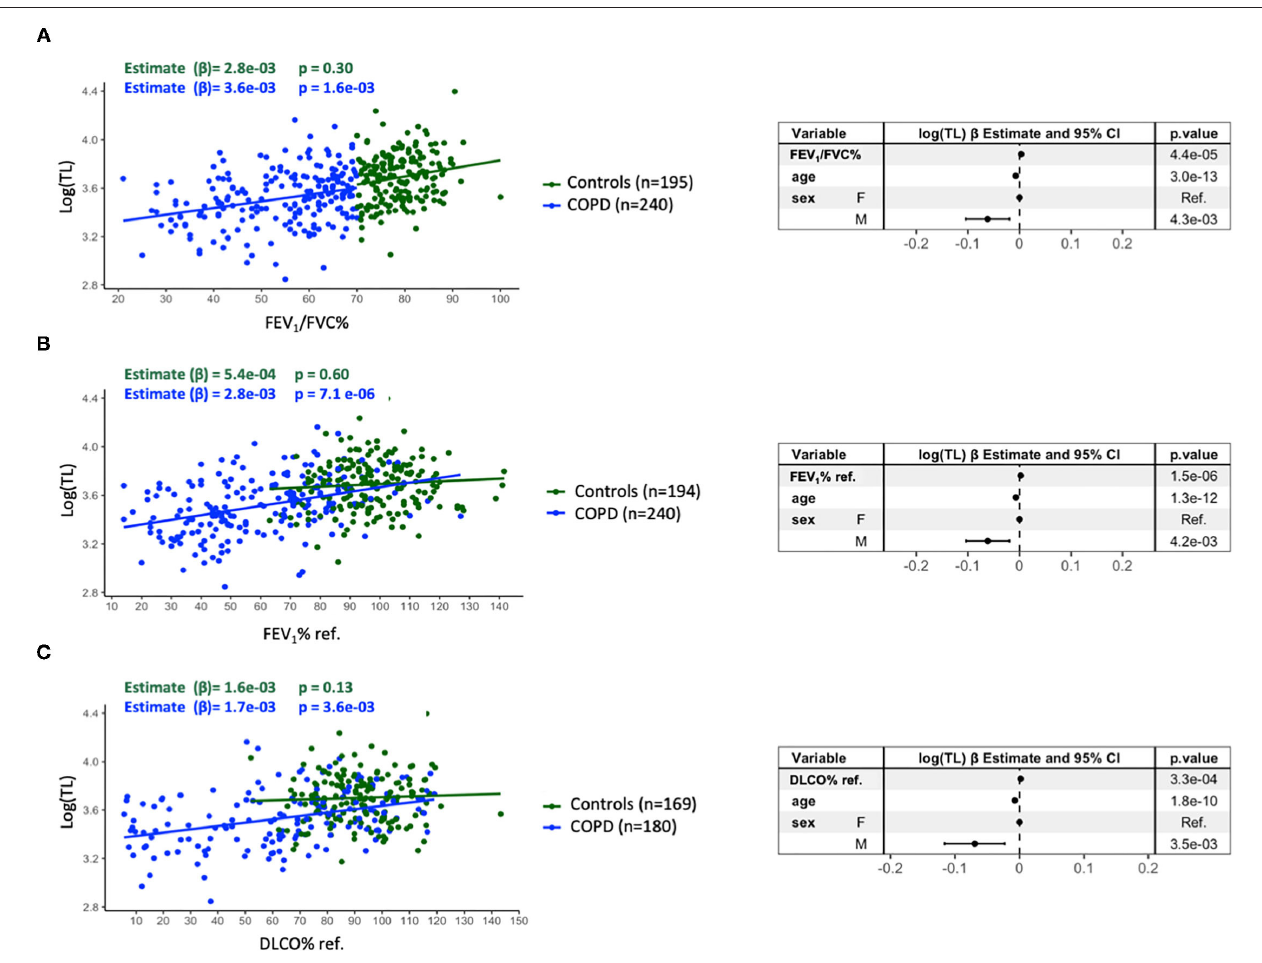
FIGURE 2 | Relationship between the TL [log(TL)] and FEV 1 /FVC% (A) , FEV 1 % ref. (B) , and DLCO% ref. (C) . The blue dots identify the patients with COPD ( A : n = 240, B : n = 240, C : n = 180) whereas the green dots correspond to controls ( A : n = 195, B : n = 194, C : n = 169). Forest plots of the linear regression models of all individuals ( A : n = 435, B : n = 434, C : n = 349) presenting the point estimates and 95% CI (whiskers) of the change in log(TL) when adjusted for the potential confounders. For further explanations, see text.